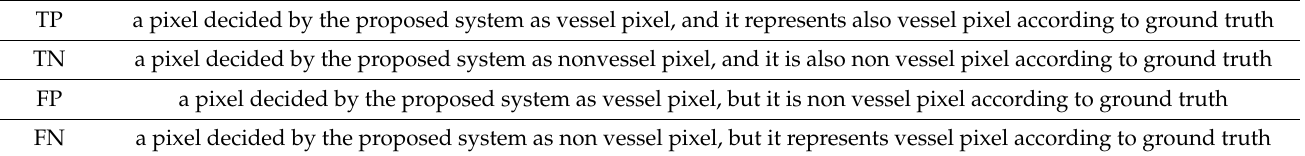
Table 1. Definitions of TP, TN, FP, and FN.